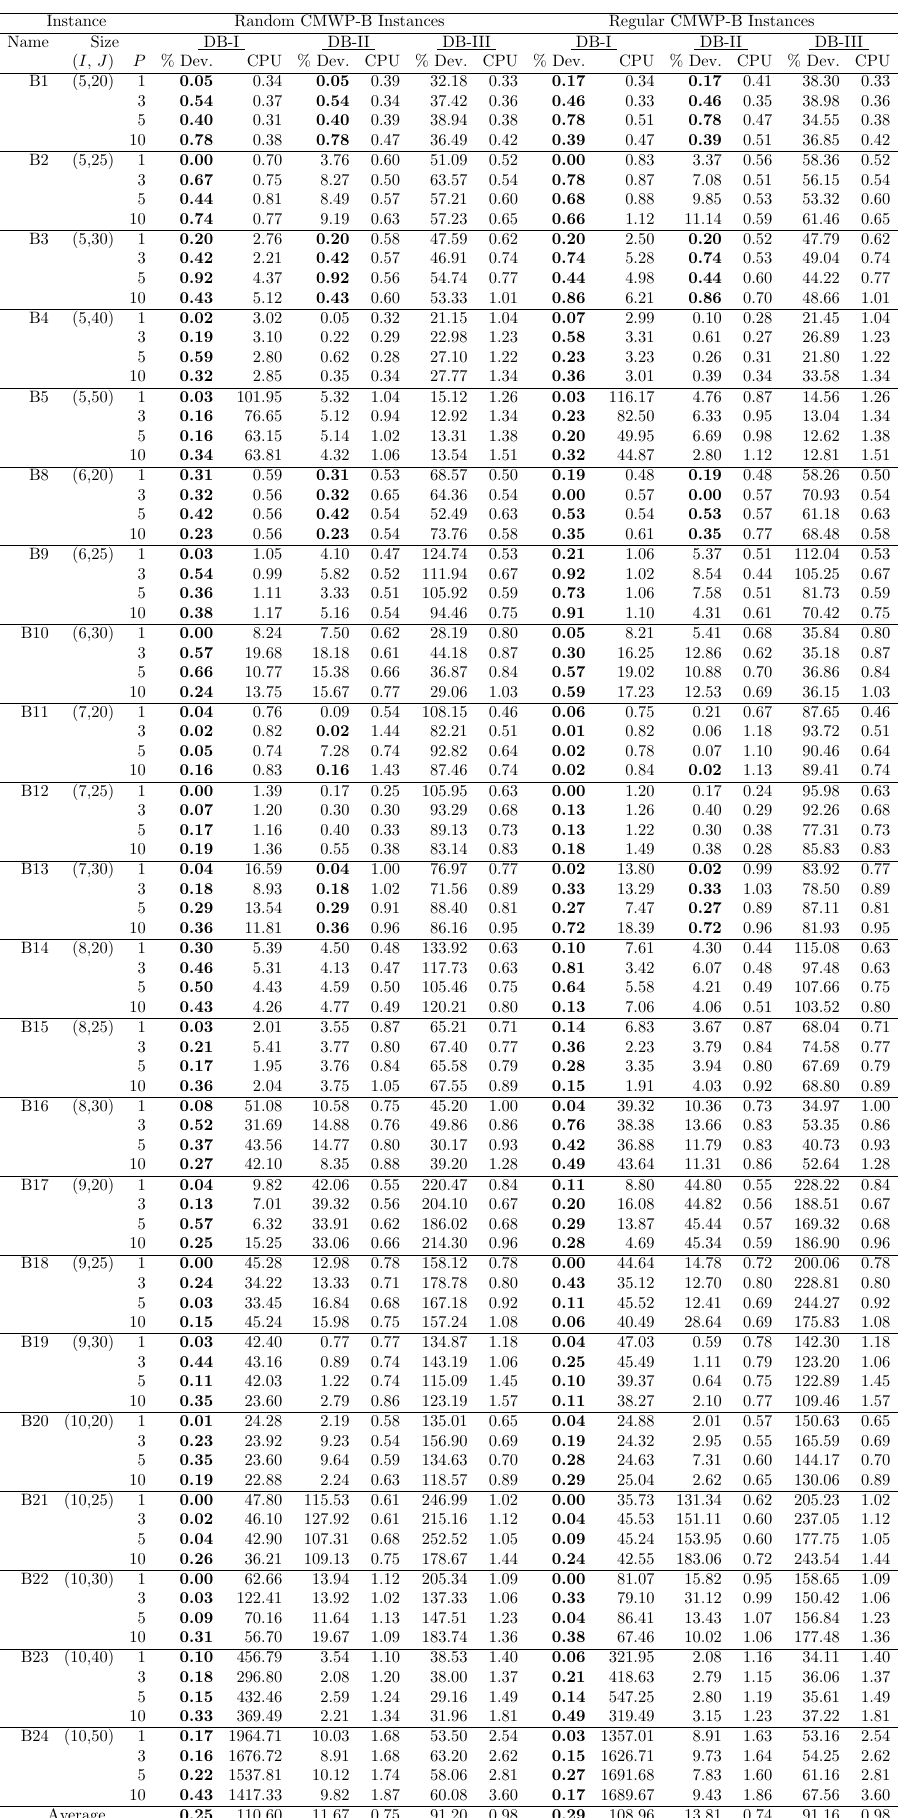
Table 3. The performance of the DB heuristics over small sized random and regular CMWP-B instances based on Boyacı [48]